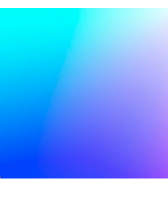
Figure 2. Blue Hues.